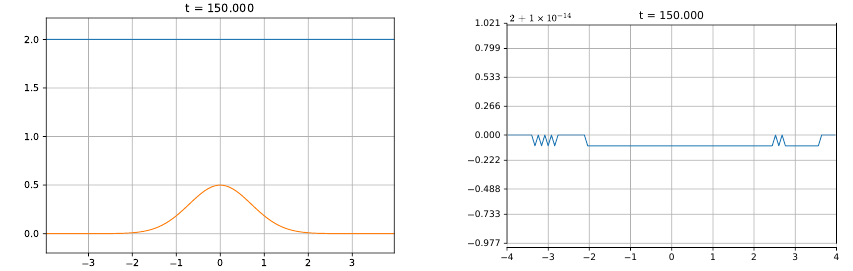
Figure 7. Free surface and bathymetry ( left ) and zoom of the free surface ( right ) at time t = 150 s.